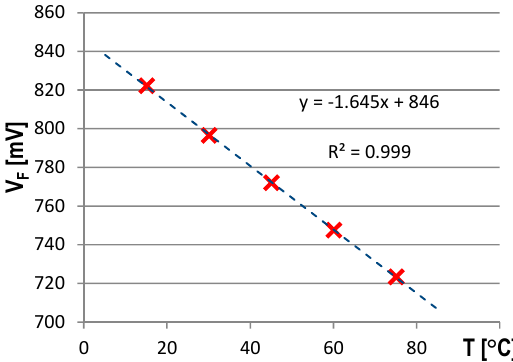
Figure 4. Voltage to temperature mapping at sense current.